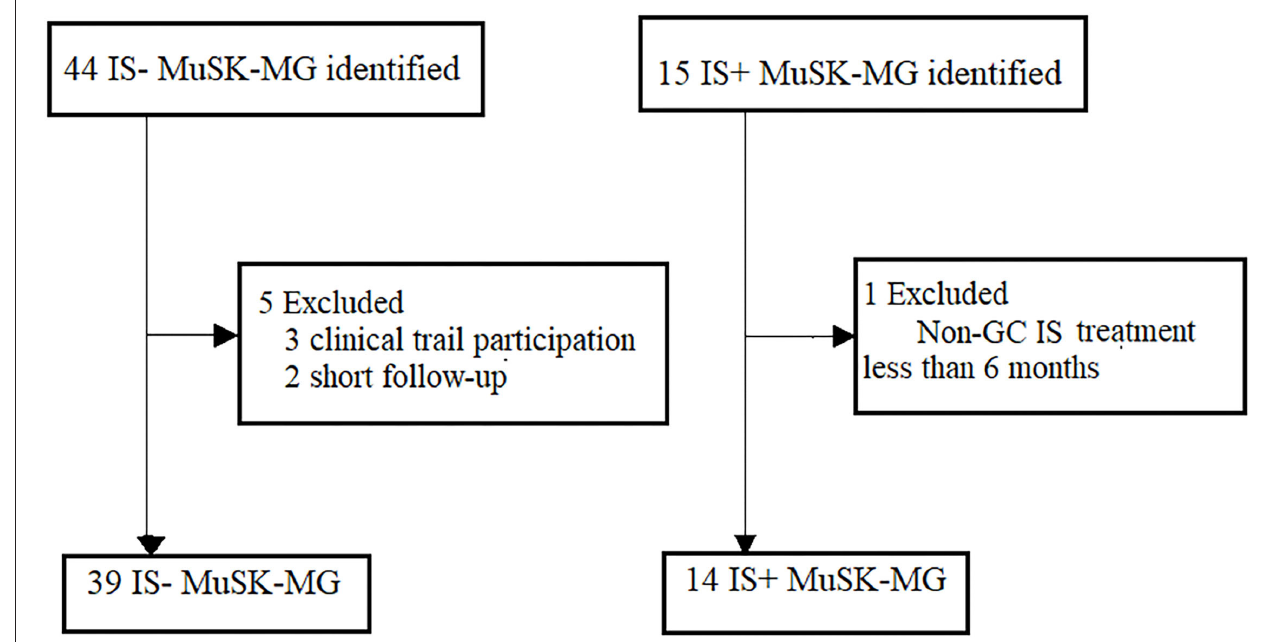
FIGURE 1 | Recruitment of patients with MuSK-MG. Patient recruitment to the different treatment groups, respectively. MuSK, muscle-specific tyrosine kinase; non-GC IS, non-glucocorticoid immunosuppressants; IS + , immunosuppressants combined with prednisone therapy; IS-, prednisone monotherapy.